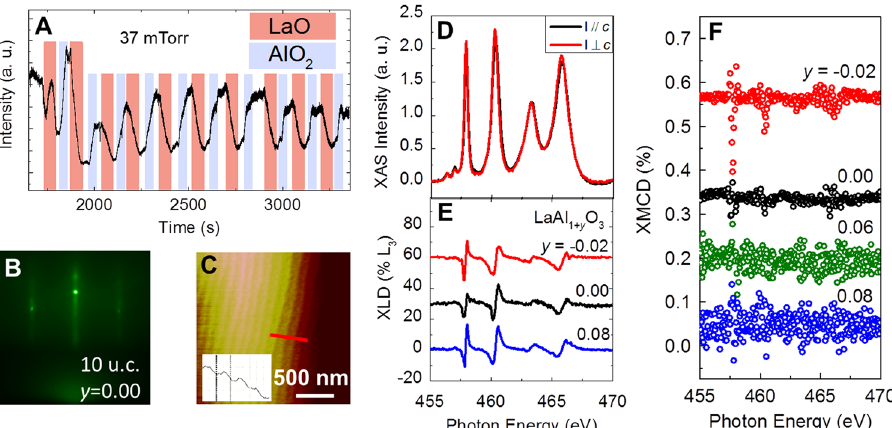
Fig. 4 a RHEED intensity oscillation during the growth of a LaAlO 3 fi lm on a SrTiO 3 substrate at an oxygen pressure of 37 mTorr. b RHEED pattern after the growth of a 10 unit-cell stoichiometric LaAlO 3 fi lm. c AFM topographic images of the 10 unit-cell LaAlO 3 fi lm on SrTiO 3 . The root mean square (RMS) roughness of the fi lm is 0.1 nm. d Ti XAS spectra measured at 13 K with a polarization parallel ( black curve ) and perpendicular ( red curve ) to the sample normal for a 10 unit-cell stoichiometric LaAlO 3 fi lm on SrTiO 3 . e Ti L 2,3 -edges XLD spectra for 3 LaAl 1+ y O 3(1+0.5 y ) /SrTiO 3 samples with y = − 0.02, 0.00, and 0.08. f XMCD observed for the in-plane geometry for 4 LaAl 1+ y O 3(1+0.5 y ) fi lms on SrTiO 3 with y = − 0.02, 0.00, 0.06, and 0.08. All samples were measured at a temperature of 13 K in a constant fi eld of ± 0.3